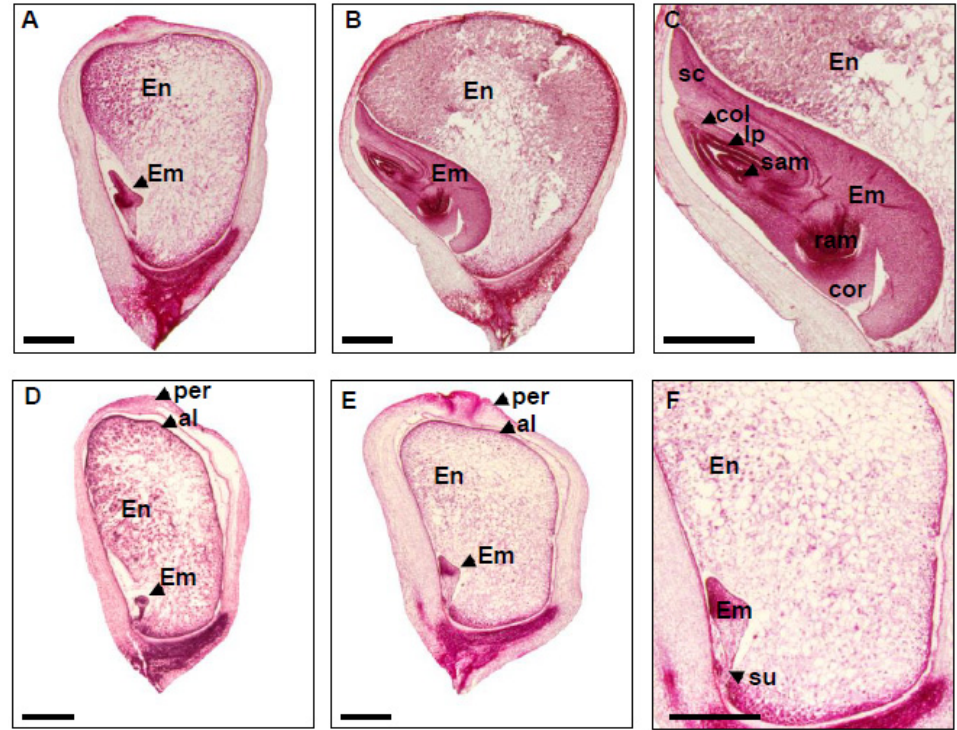
Figure 4. Embryo and endosperm development are arrested in the dek48 mutant. ( A – F ) Paraffin sections of wild-type and dek48-1 kernels at 9 DAP and 15 DAP. WT kernels at 9 DAP ( A ) and 15 DAP ( B , C ); dek48-1 kernels at 9 DAP ( D ) and 15 DAP ( E , F ). ( C , F ) are enlarged views of the embryo in ( B , E ), respectively. Em, embryo; En, endosperm; sc, scutellum; col, coleoptile; lp, leaf primordial; per, pericarp; al, aleurone; su, suspensor; cor, coleorhizae; sam, shoot apical meristem; ram, root apical meristem. Scale bars = 1 mm in ( A , B , D , E ); 0.5 mm in ( C , F ).